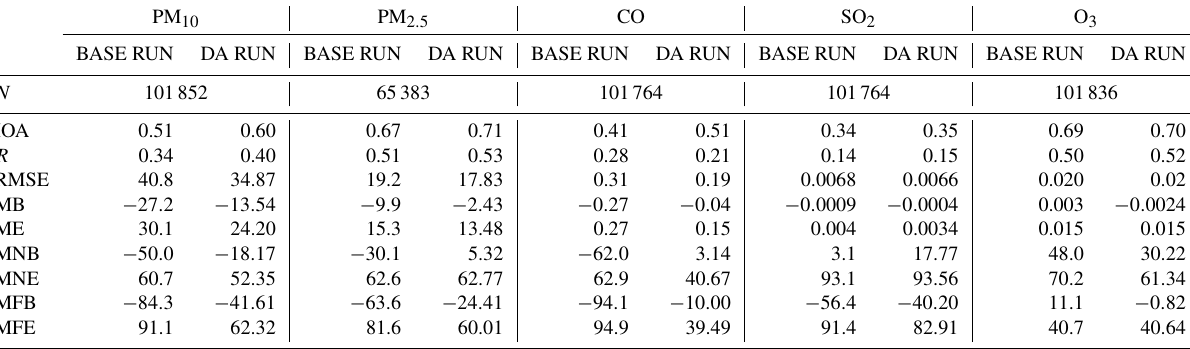
Table 1. Statistical metrics from BASE RUN and DA RUN with Air Korea observations over the entire period of the KORUS-AQ campaign.